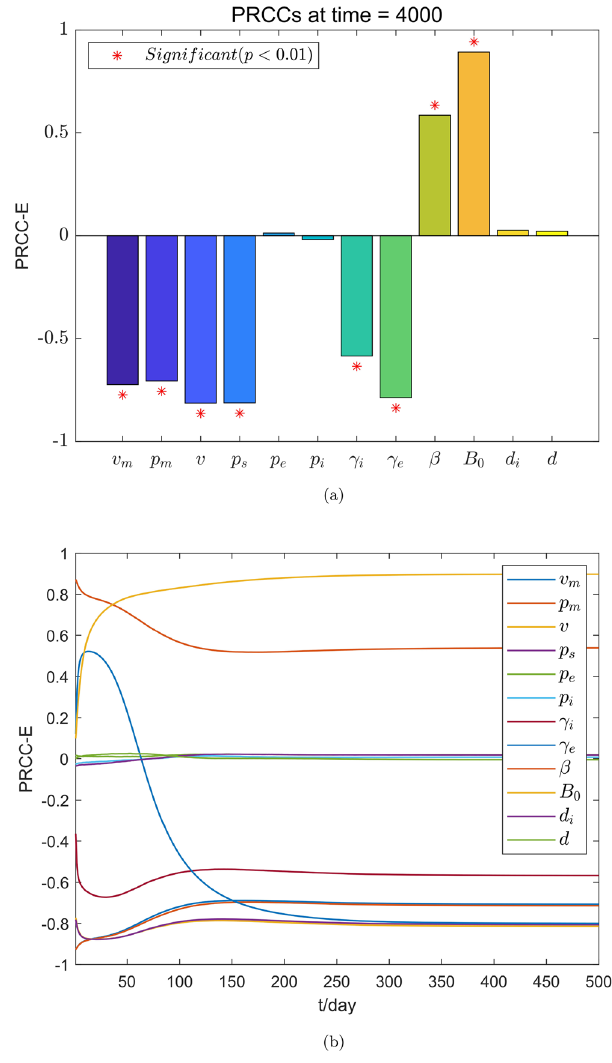
Figure 2. The PRCC value of each parameter to E ( t ). ( a ) The PRCC value of the parameter to E ( t ) at time t = 4000 . ( b ) The PRCC value of the parameter against E ( t ) changes over